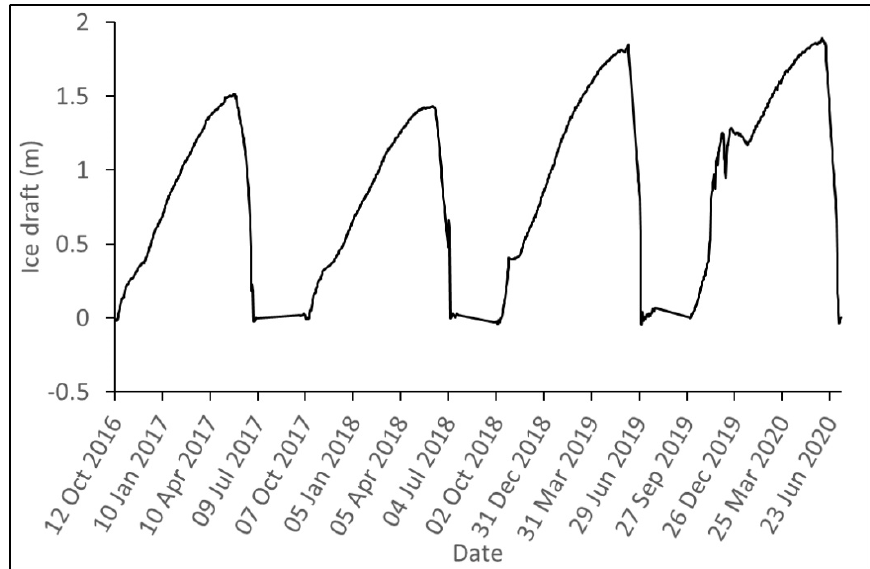
Figure 2. Ice draft changes from an ice profiler located at harbor of Cambridge Bay.